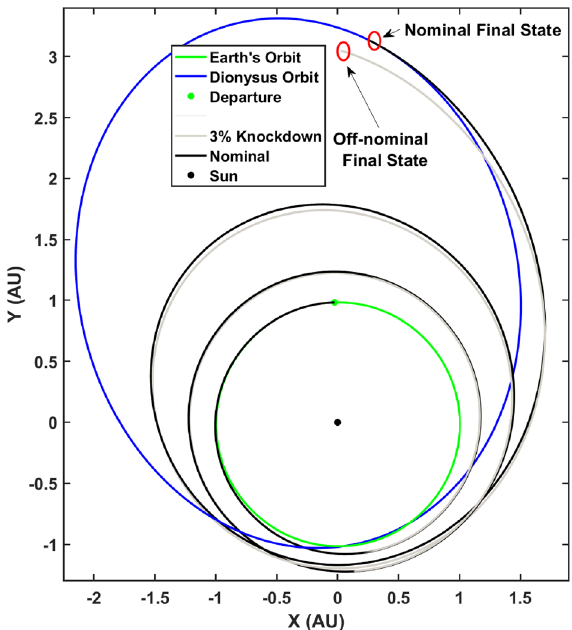
Figure 9. Nominal and 3% knockdown trajectories.